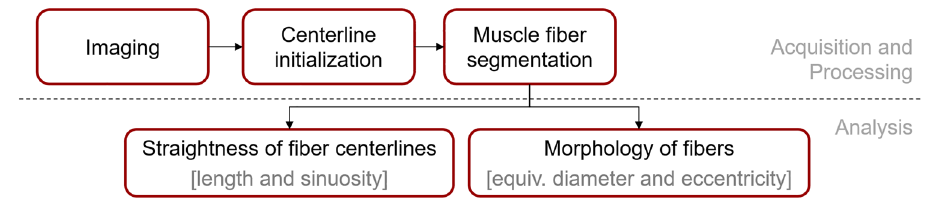
Figure 1. The processing pipeline for each